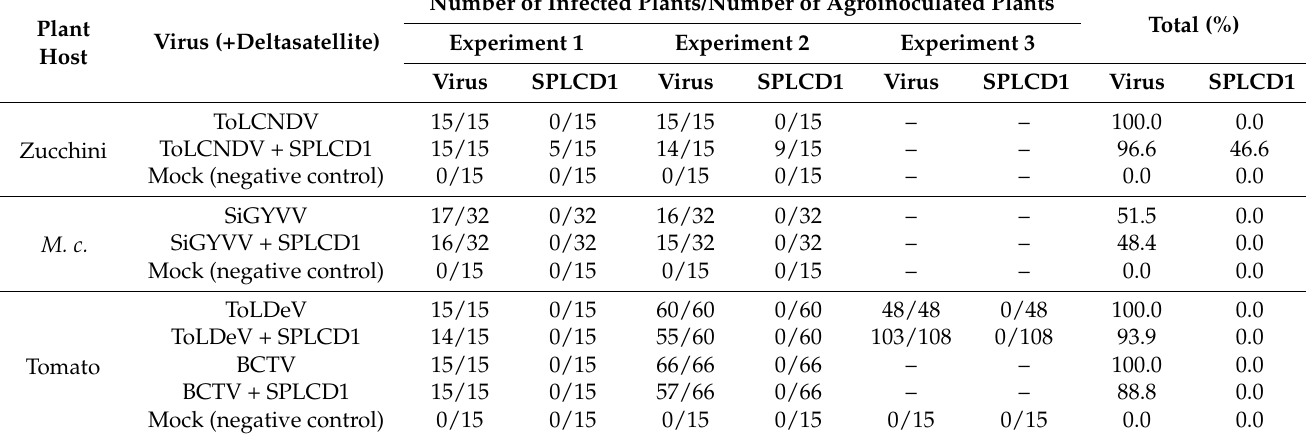
Table 3. Infectivity of sweet potato leaf curl deltasatellite 1 (SPLCD1) in the presence of various geminivirids in zucchini, Malvastrum coromandelianum , and tomato plants. Plant